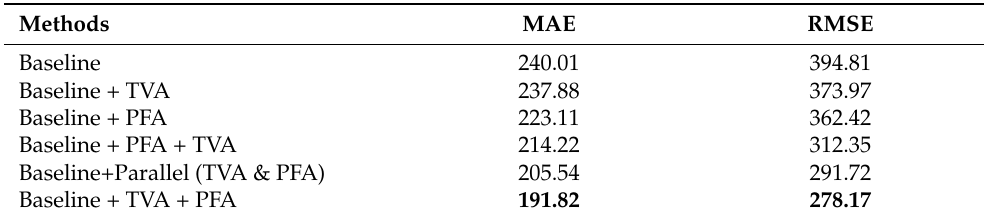
Table 4. Comparative results of the baseline with different compound modes on the ship dataset. The best performances are highlighted in bold .